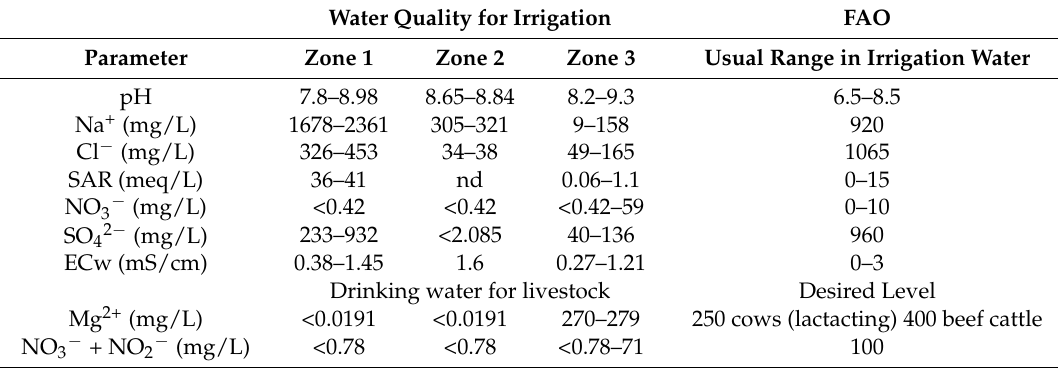
Table 1. Parameters to evaluate common irrigation water quality problems and levels detected in the study area. nd = not detected.